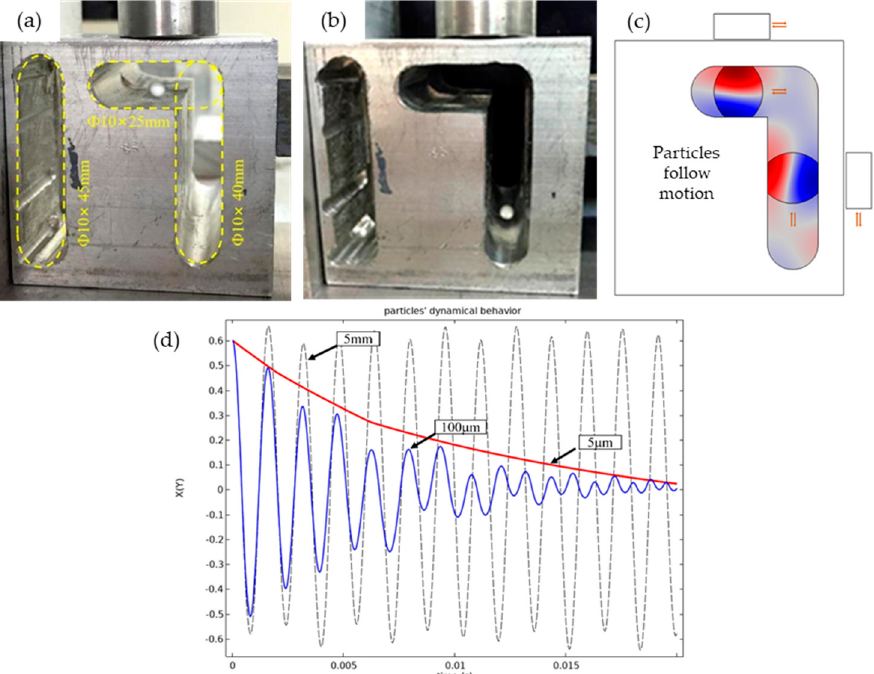
Figure 7. ( a , b ) Diagram of the horizontal and vertical suspension effects in the long circular channel; ( c ) Diagram of particles’ follow motion and local acoustic field; ( d ) Diagram of the suspension stability test results of 2 to 20 mm foam balls.